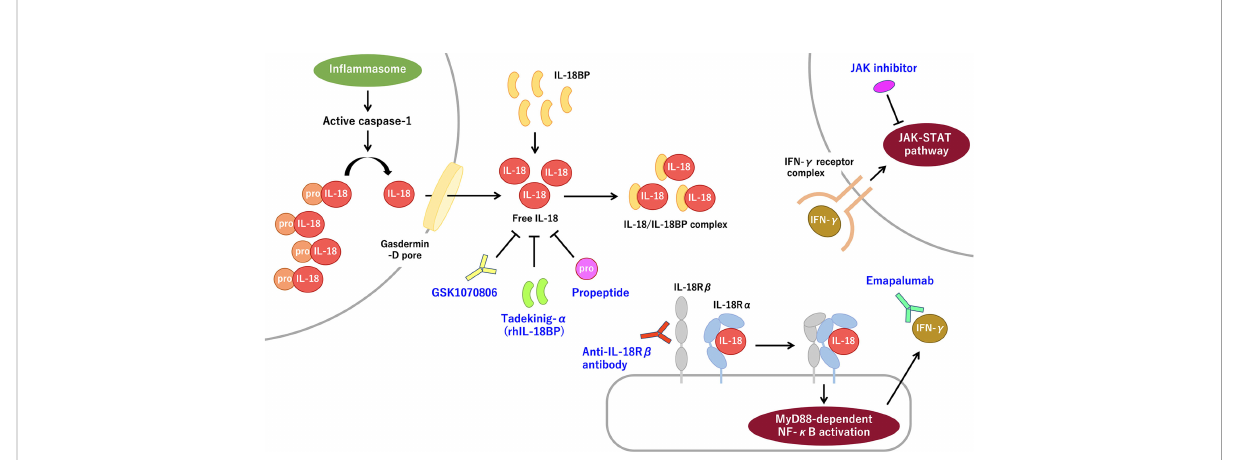
FIGURE 1 The IL-18 signaling pathway and promising molecular targeted therapies for IL-18 and IL-18-related proteins. Pro-IL-8 is constitutively expressed and accumulated intracellularly. In fl ammasome-mediated caspase-1 activation induces pro-IL-18 cleavage. Mature IL-18 is released through the gasdermin-D pore and binds with low af fi nity to IL-18R a , thereby recruiting IL-18R b . The IL-18/IL-18R complex induces MyD88- dependent NF- k B activation, which subsequently promotes IFN- g secretion primarily from T-cells and NK cells. IFN- g promotes strong proin fl ammatory signaling through the IFN- g receptor-mediated JAK – STAT pathway. The extracellular IL-18 mostly exists as the inactive form of the IL-18/IL-18BP complex. Free IL-18, bioactive unbound form of IL-18, is virtually absent in normal and most pathological conditions. The rhIL-18BP tadekinig- a is the most well-recognized IL-18-targeting therapy. Humanized anti-IL-18 monoclonal antibody, called GSK1070806, and IL-18 propeptide can also inhibit IL-18 signaling. Anti-IL-18R b (i.e., IL-1R7) antibody can speci fi cally block IL-18R b without interfering with anti-in fl ammatory IL-37 signaling. Inhibiting the IFN- g signaling pathway by using the anti-IFN- g antibody emapalumab or a JAK inhibitor, is a promising therapeutic strategy for IL-18-mediated systemic autoin fl ammatory diseases. IFN- g , interferon- g ; IL, interleukin; IL-18BP, interleukin- 18 binding protein; IL-18R a / b , interleukin-18 receptor a / b chain; IL-1R7, interleukin-1 receptor 7; JAK, Janus kinase; MyD88, myeloid differentiation primary response 88; NF- k B, nuclear factor- k B; NK, natural killer; rhIL-18BP, recombinant human IL-18 binding protein; STAT, signal transducer and activator of